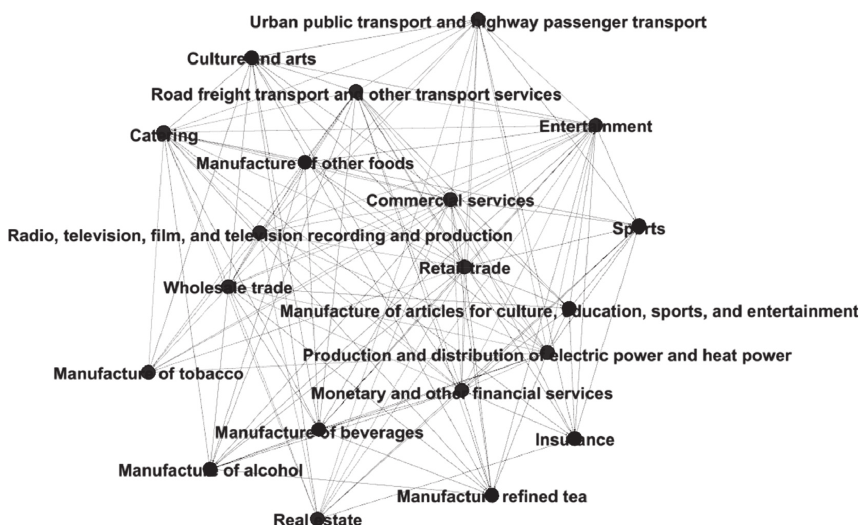
Figure 2: Diagram of the direct industrial related network of the entertainment industry.